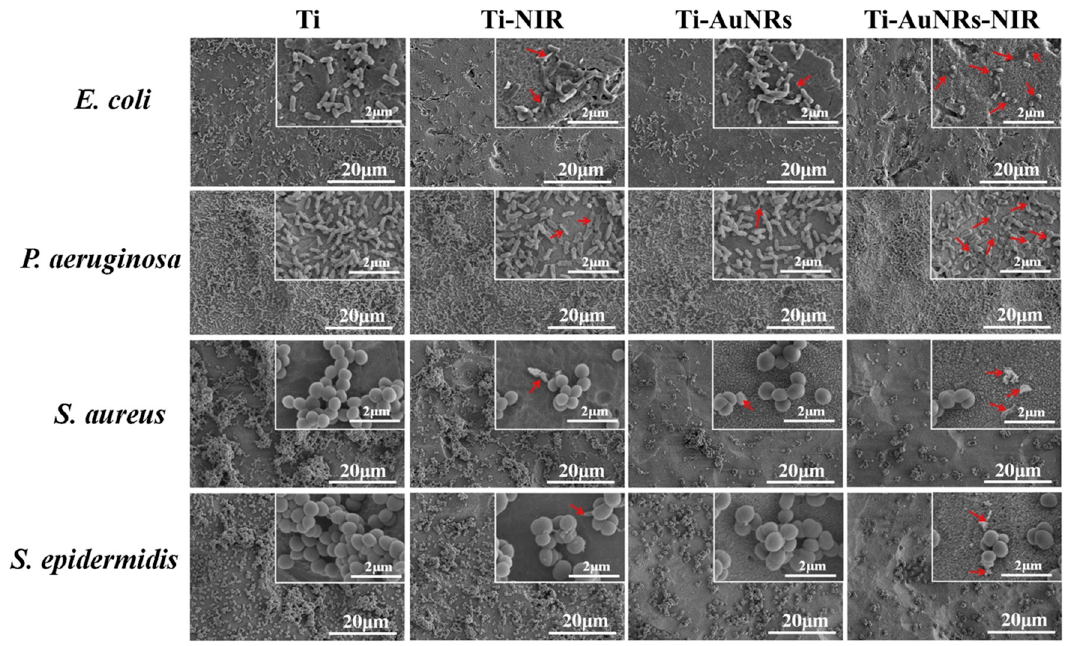
Figure 5. SEM images of E. coli , Pseudomonas aeruginosa , S. aureus, and S. epidermidis on titanium (Ti) and Ti-gold nanorod (Ti-AuNRs) surfaces before and after NIR irradiation (20 min); the bacteria concentration was 10 7 colony-forming units / mL. Red arrows show the damaged microbial cell structure. Reproduced from [52], with permission from Elsevier, 2019.